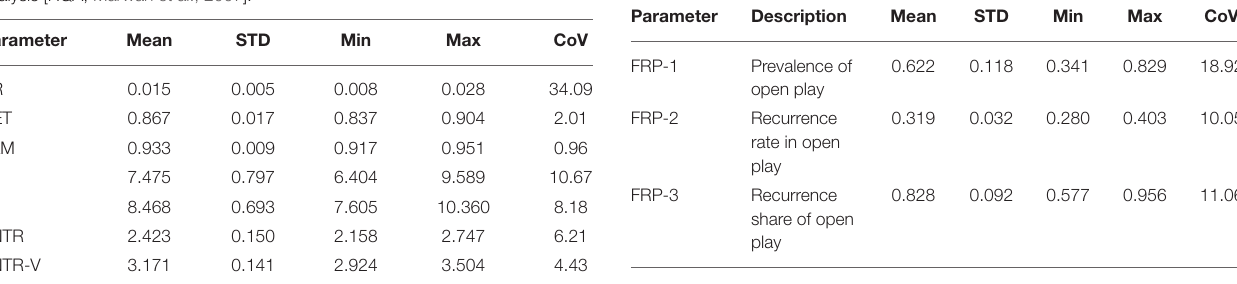
TABLE 1 | Descriptive statistics of the 21 football matches, including the coefficient of variation (CoV) for traditional parameters of recurrence quantification analysis [RQA; Marwan et al., 2007].